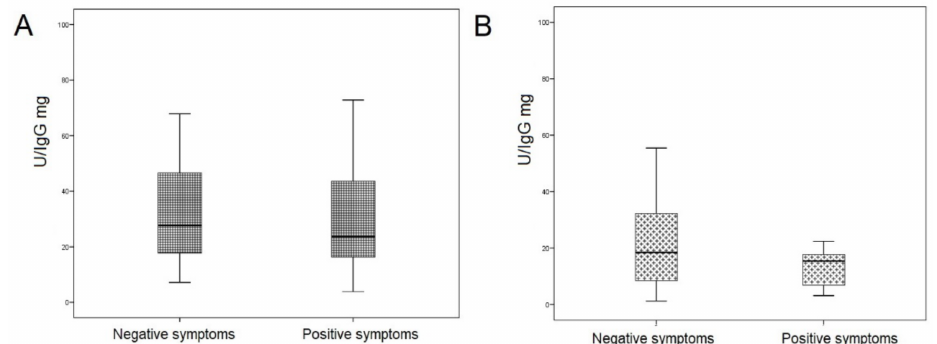
Figure 5. SOD activity of IgG in patients with schizophrenia depending on the leading symptomology. ( A ) Patients with schizophrenia in remission. ( B ) Patients with acute schizophrenia. Note: U corresponds to the amount of enzyme that catalyzes the conversion of 1 µ mol of substrate in 1 min at +25 ◦